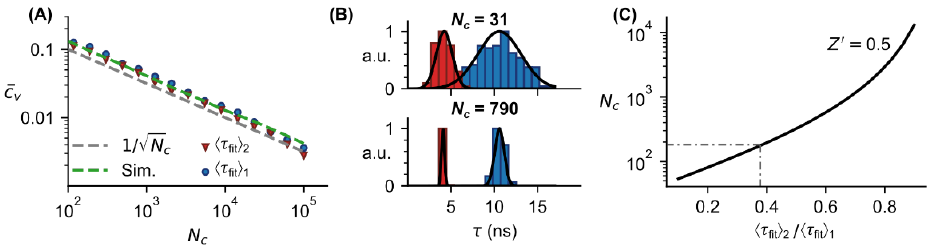
Figure 6. Photon statistics in FL measurements. ( A ) Precision vs. photon counts. Experimental FL measurements of two fluorophores (2-amino-acridone, red and fluorescein, blue) and correspond- ing Monte Carlo simulations show that the precision 𝑐̅ v depends on the photon counts 𝑁 c with a 1/√𝑁 c -dependency independently of the absolute lifetime value as predicted by Poisson statistics. ( B ) Representative distribution of FLs at low 𝑁 c (upper panel) and high 𝑁 c (lower panel) for the two fluorophores in ( A ) show that for the larger 𝑁 c value the standard variation 𝜎 is lower while the mean values 𝜇 are the same. In experiments, overlapping distributions ( B , upper panel) are critical for differentiating multiple fluorophores, so higher photon counts are preferable, but in general at cost of longer measurement times. ( C ) Successful differentiation requires a sufficient distance between these two distributions, which can be achieved for Z (cid:48) = 0.5 (Equation (6)), corresponding to a distance equal to six times the sum of the standard deviations of two fluorophores. Such a distance is described in [29] as an excellent assay, and the number of photons required compared with the ratio of the mean values of two FLs to achieve this is shown here. The grey dashed/dotted line indicates the minimum required photon counts for distinguishing the fluorophores in ( A , B ). Error bars in ( A ) are smaller than the